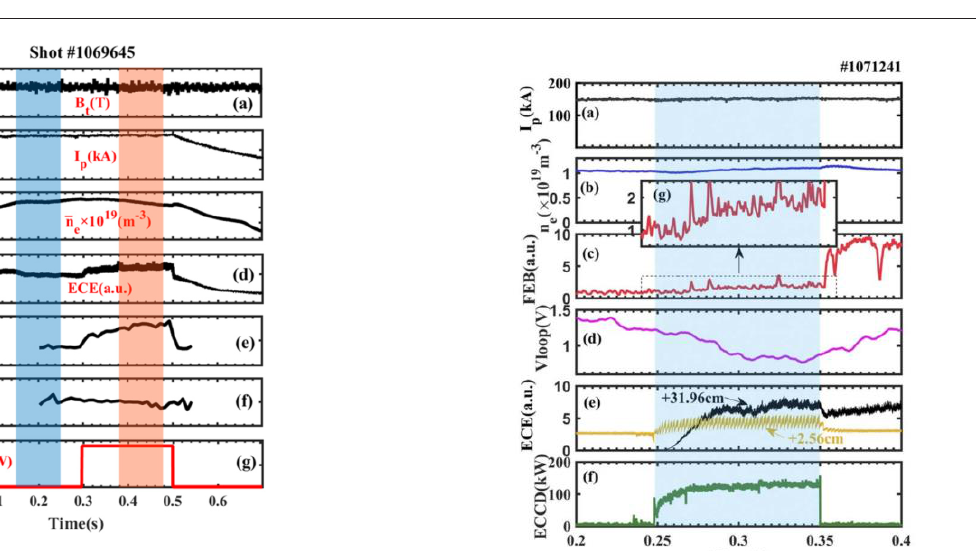
Fig. 9. Time evolution of plasma parameters for shot 1069645: ( a ) toroidal field B t ; ( b ) plasma current I p ; ( c ) line- averaged electron density n ̅ e ; ( d ) electron temperature at r / a = 0.72 by ECE (no calibration); ( e )-( f ) the core of plasma electron and ion temperature obtained by XICS; ( g ) the ECRH power [14].